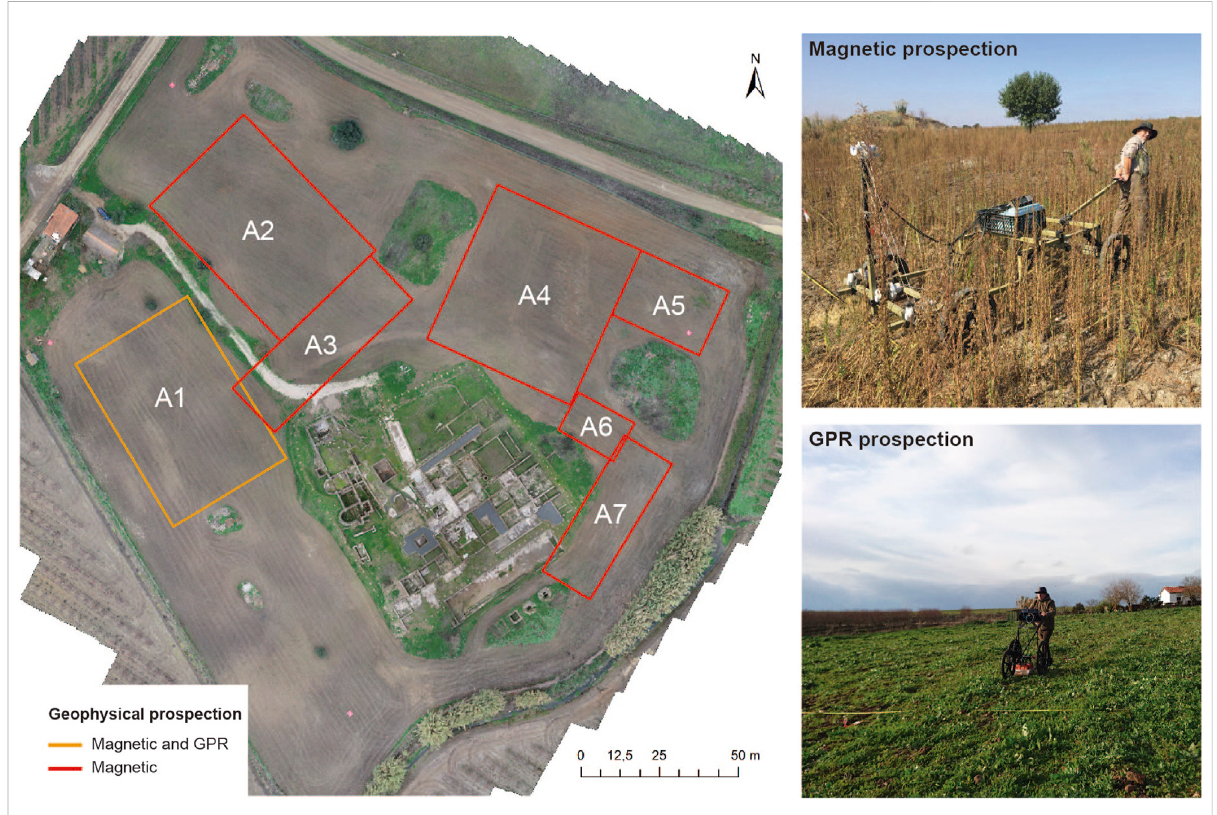
FIGURE 3 Location of the prospected sectors. The GPR survey was carried out in sector A1, and the magnetic survey in all sectors.